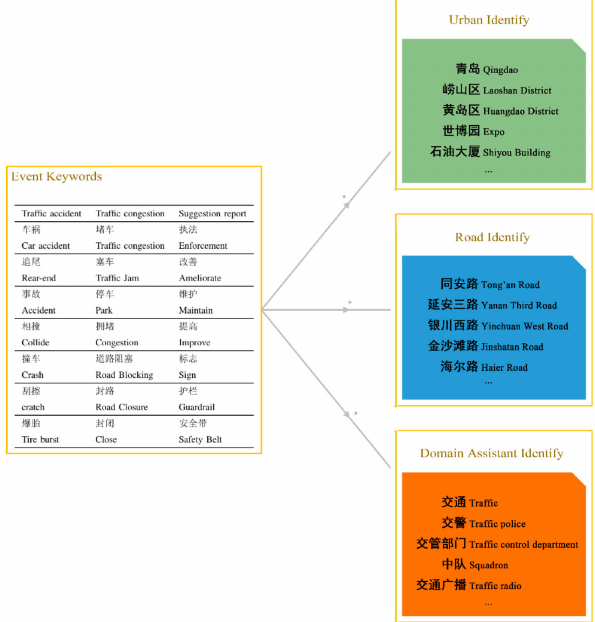
Figure 2. Traffic keywords for social